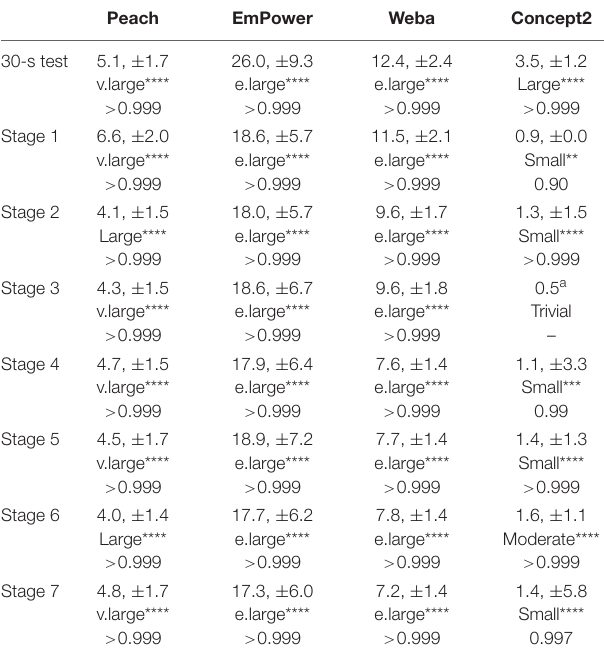
TABLE 2 | Differences from the Concept2 in mean systematic error across the stages for Peach, EmPower, and Weba. Data are mean (%), ± 90% compatibility limits, with observed magnitude and p -values for inferiority and superiority tests ( p − / p + ).